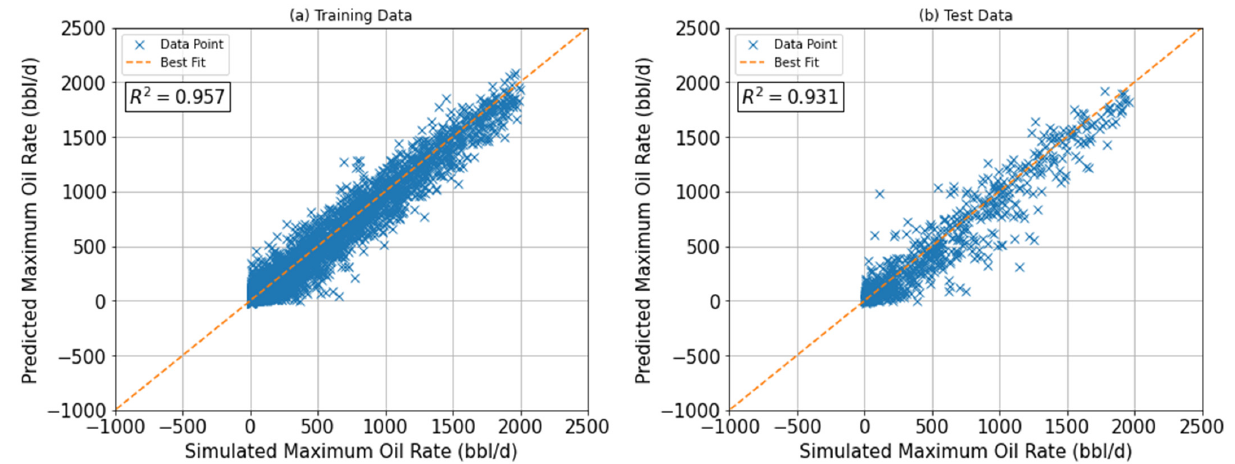
Figure 8. Predicted and simulated plot of ( a ) training data and ( b ) testing data for maximum oil rate—neural network model.